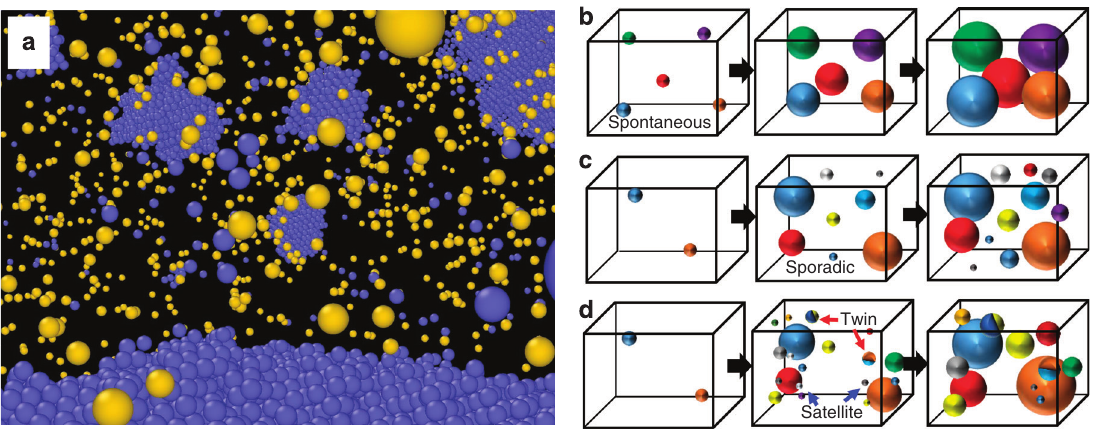
Fig. 7 Local heterogeneity in spatial distribution of grains during homogeneous nucleation. a Snapshot of atomic con fi guration around the surface of a previously existing large grain at 300 ps for the 0.67 T m calculation. Only atoms with body-centred cubic ( blue atoms ) and ICO ( yellow atoms ) con fi gurations, as classi fi ed by adaptive CNA, are shown. b - d Schematic illustration of models for homogeneous nucleation and solidi fi cation: b spontaneous nucleation model 51 , c sporadic nucleation model 51 and d local heterogeneity model proposed in this